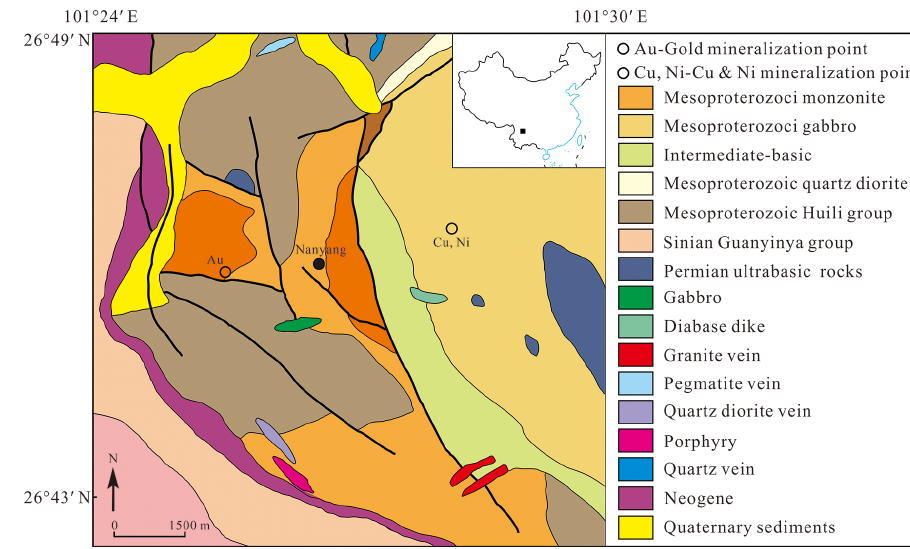
Figure 1. Geologic map of the locality. Modified from Li et al. (2019).